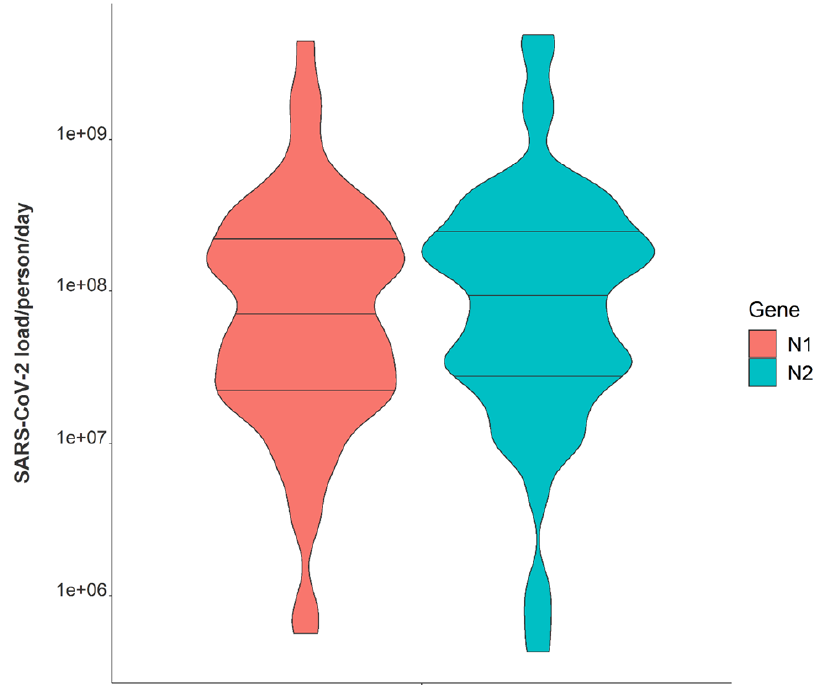
Figure 3. Violin plot showing distributions of N1 and N2 average daily wastewater viral loads per individual in isolation from 1 February 2021–21 May 2021. Note: Markers shown are median, 25th and 75th quantiles.